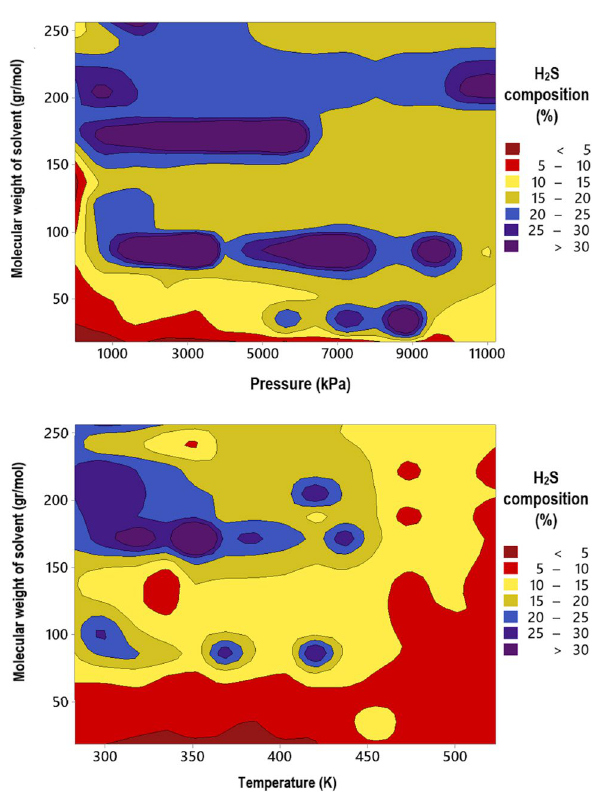
Figure 12. Contour plot of the alternation of H 2 S solubility over various ranges of pressures, temperatures and the molecular weights of solvents (created by Minitab 19 150